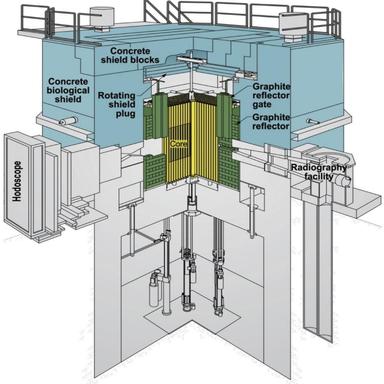
Isometric Overview of TREAT Features, ¾ Section View (.